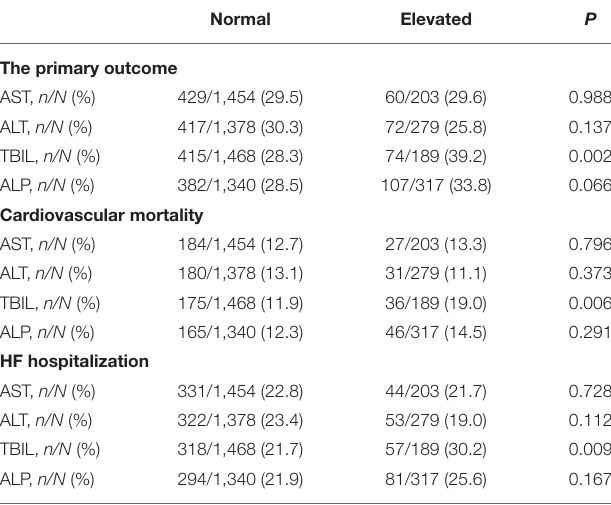
TABLE 2 | Numbers and percentages of outcome